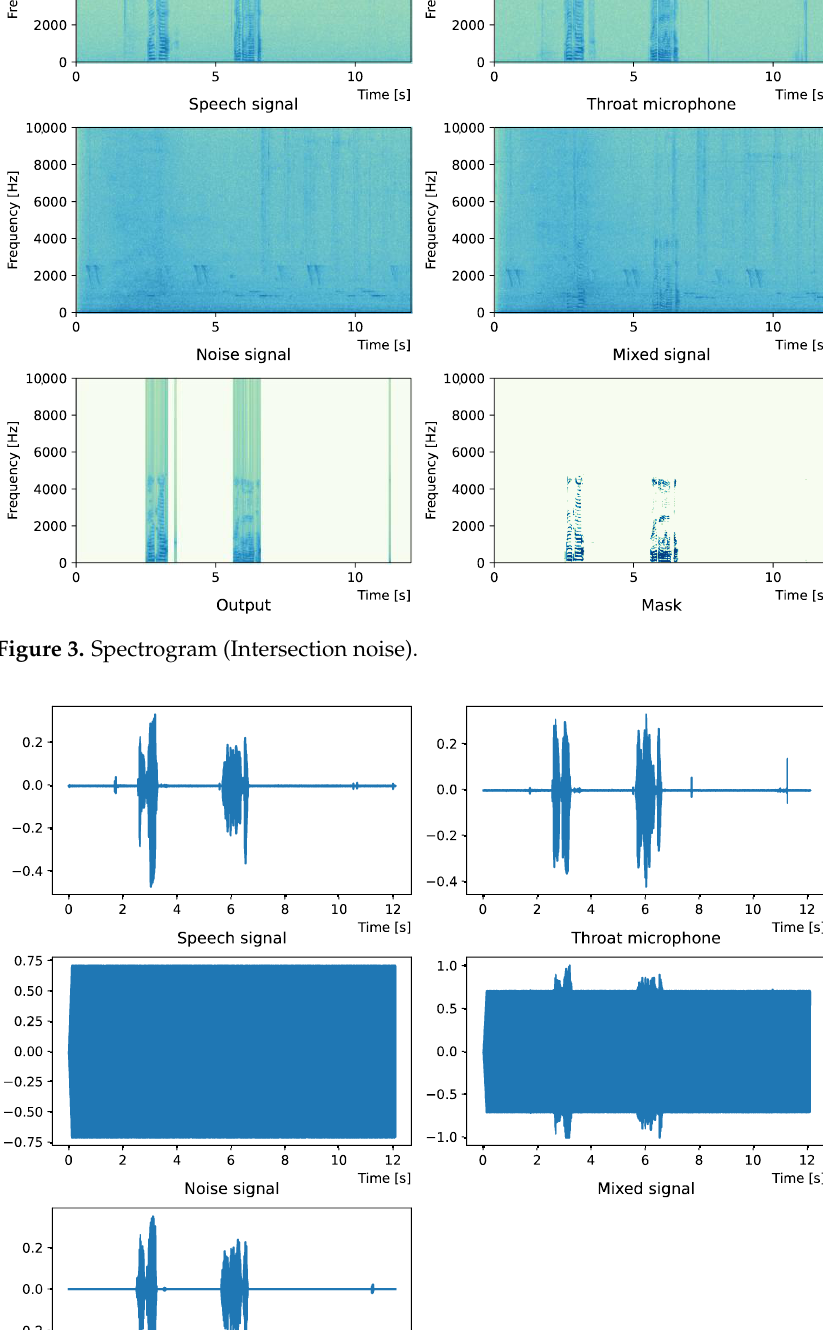
Figure 4. Waveform (White noise (0 dB)).